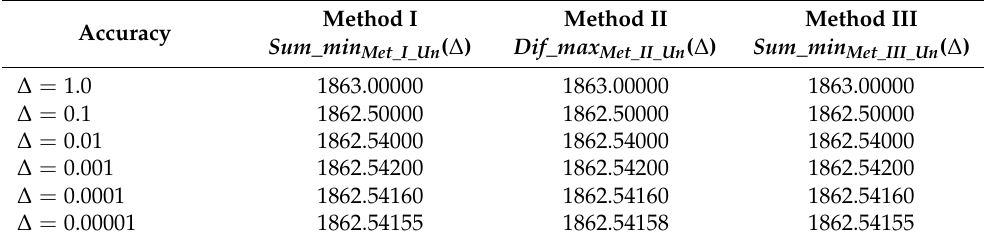
Table 20. Estimated lines lengths d ∆ of the reconstructed image for a given accuracy ∆ using the methods proposed by the